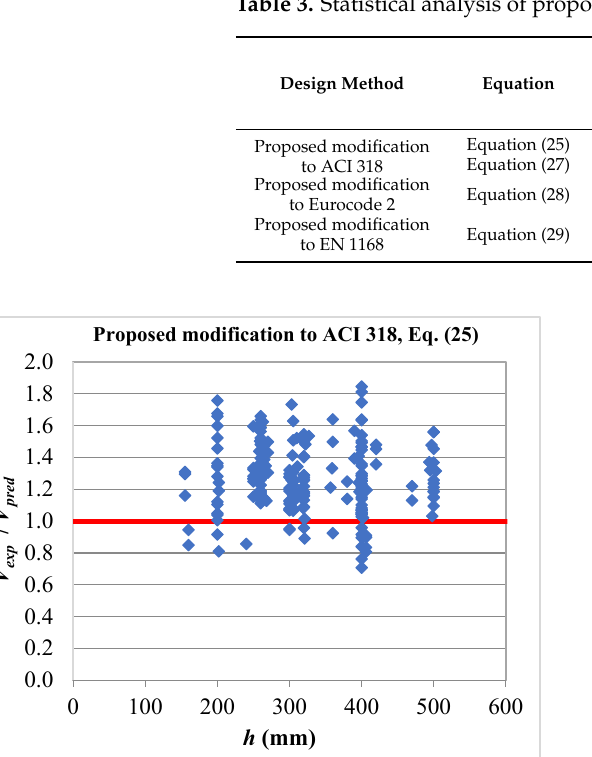
Table 3. Statistical analysis of proposed design equations.